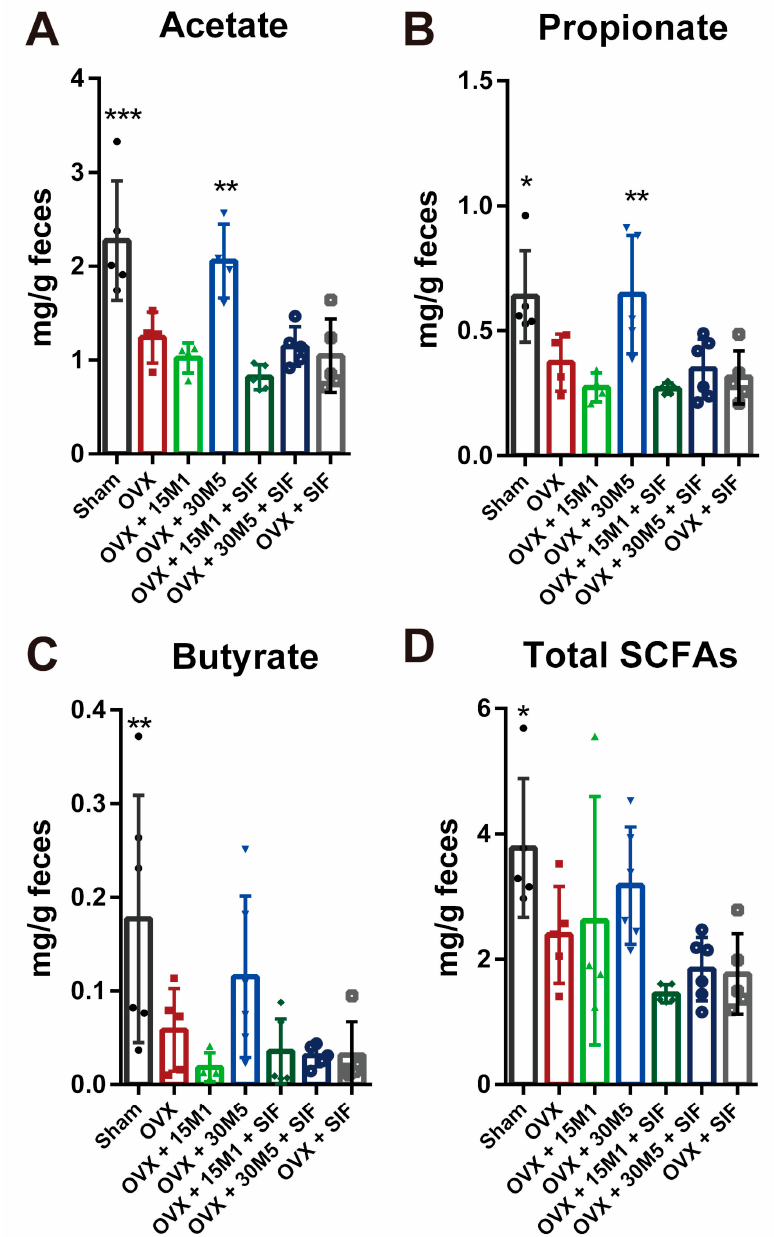
Figure 9. Fecal Short-Chain Fatty Acids (SCFAs). ( A ) Acetate. ( B ) Propionate. ( C ) Butyrate. ( D ) Total SCFAs. * p < 0.05, ** p < 0.01, *** p < 0.001 compared with the OVX group. Data present as the means ± SD. Significant differences between study groups were evaluated using ordinary one-way analysis of variance (ANOVA) and uncorrected Fisher’s LSD multiple comparison test.